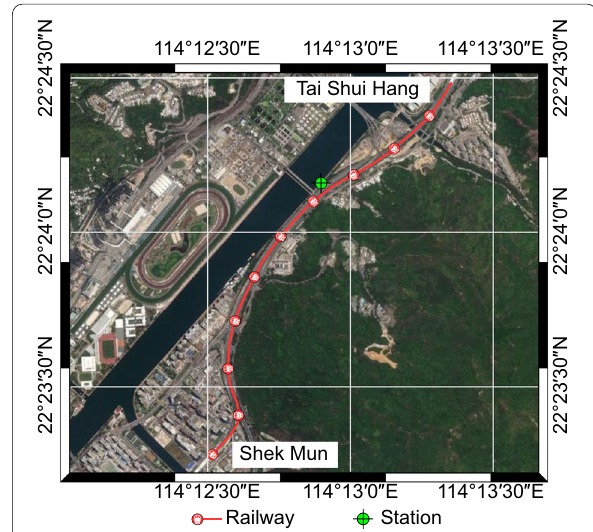
Fig. 2 Spatial distribution of the SS receiver and the MTR railway line where the MS receiver was